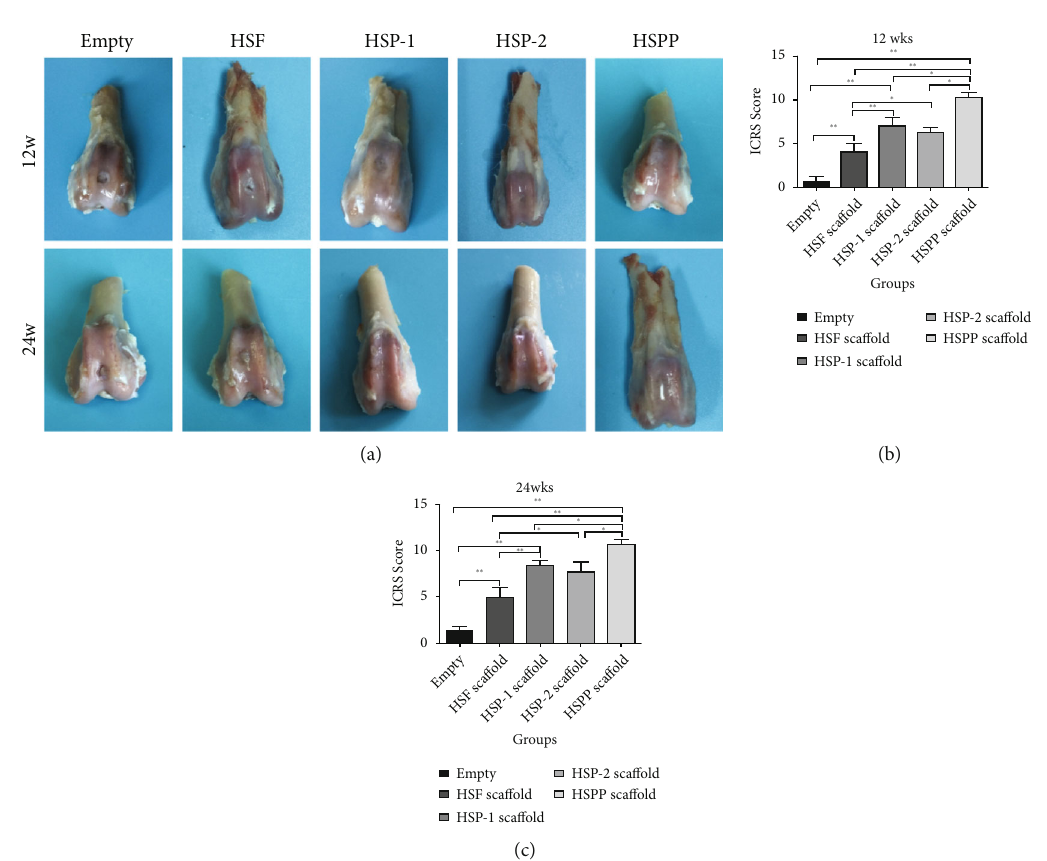
Figure 9: Appearance of gross specimens and ICRs scores at 12 and 24 weeks in each